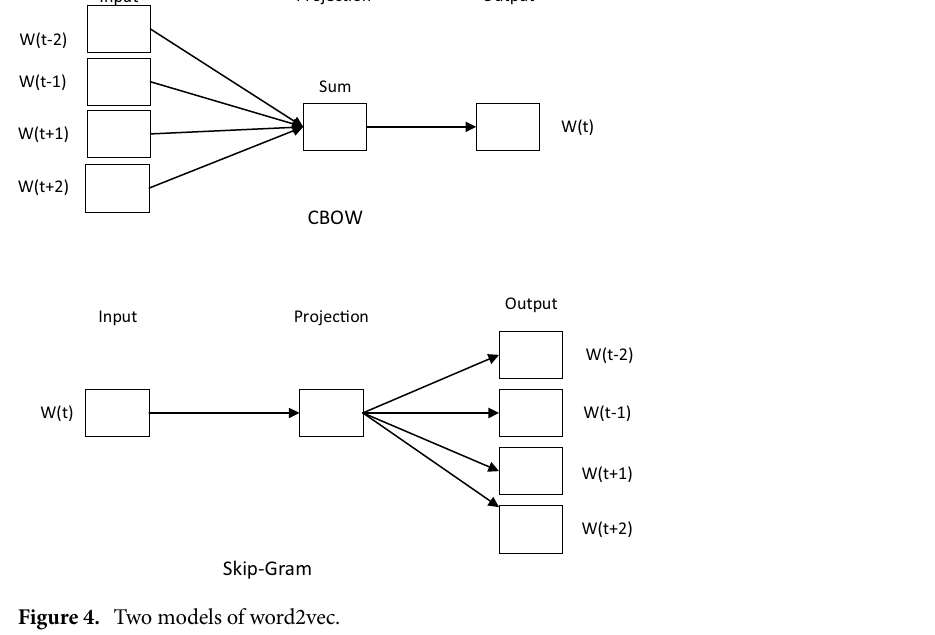
Figure 4. Two models of